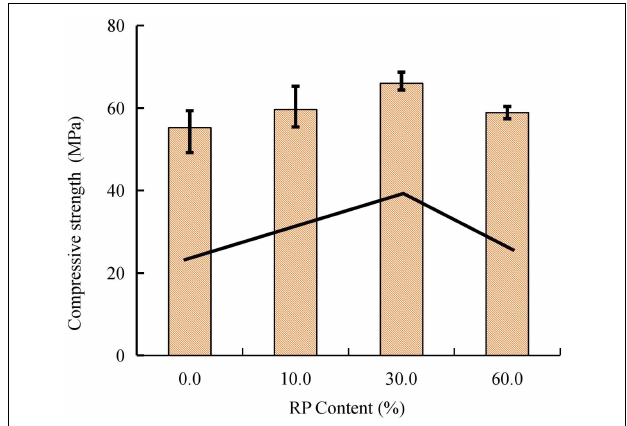
FIGURE 7 | Compressive strength of HDCCs.